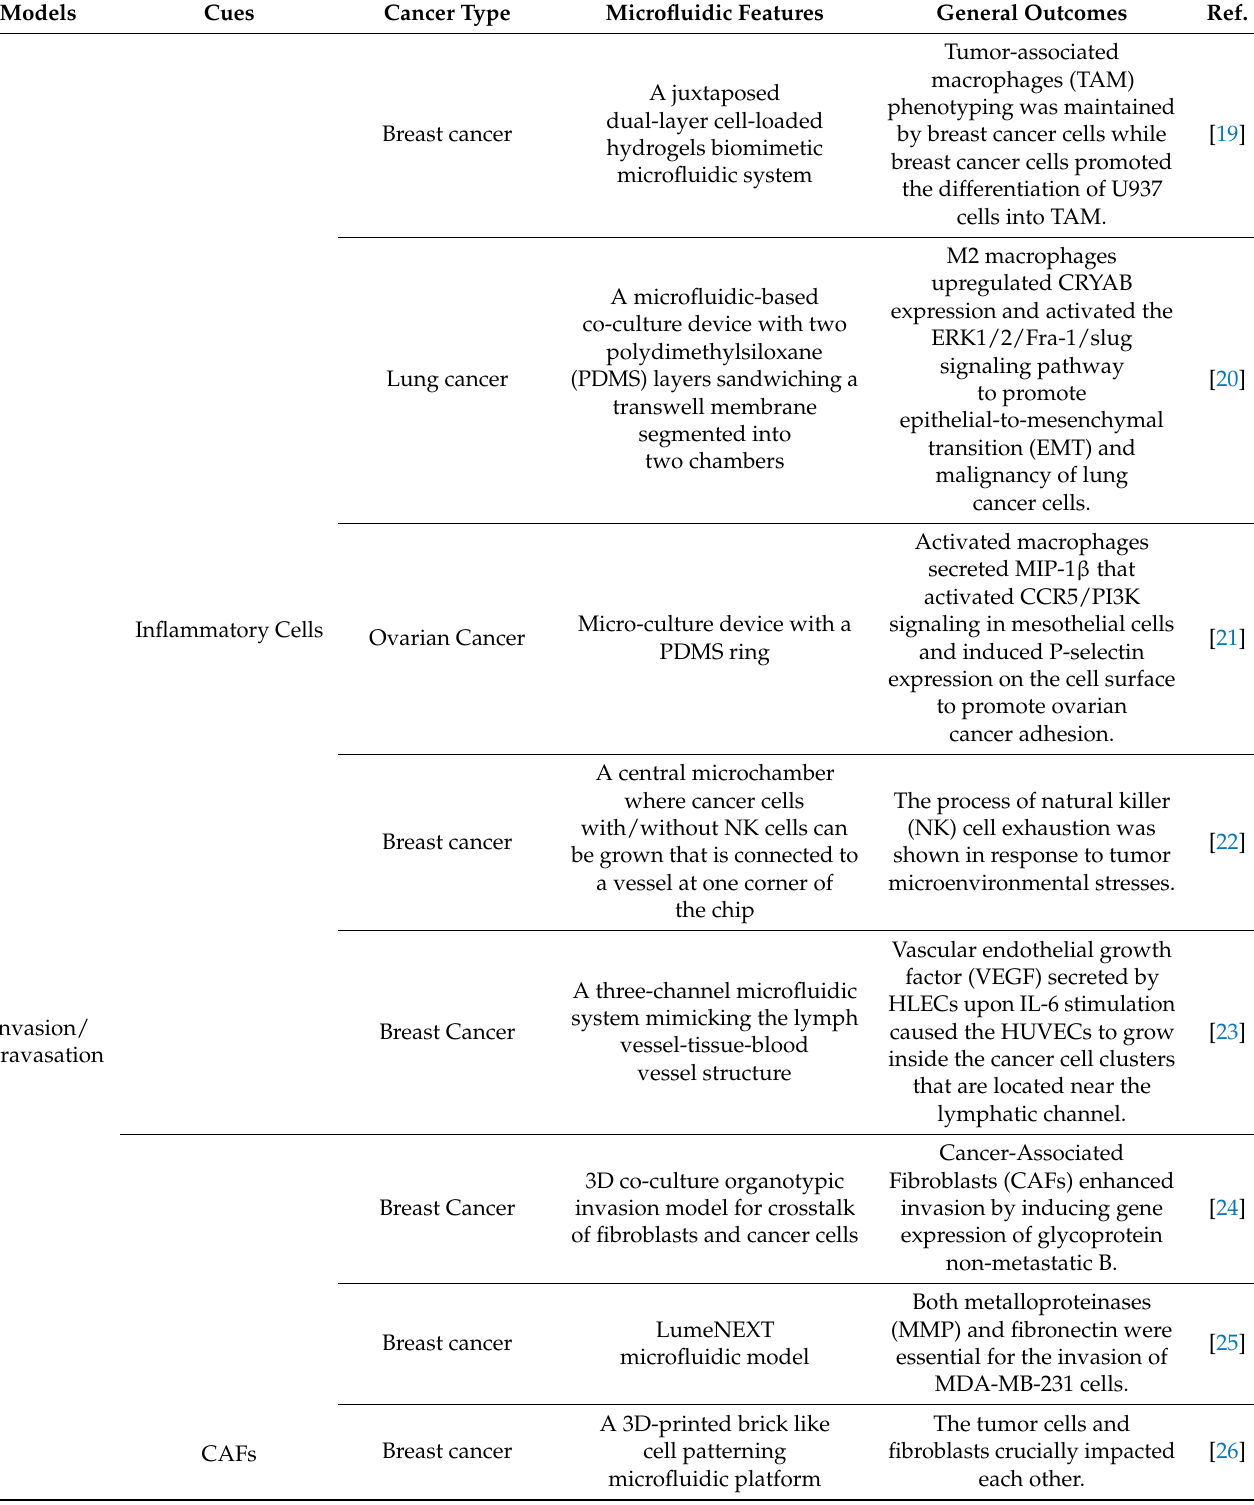
Table 1. Cancer-on-a-chip microfluidic